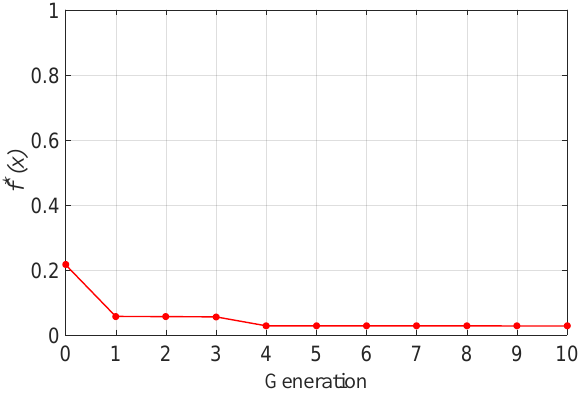
Figure 18. Value of the evaluation function × generation of the genetic